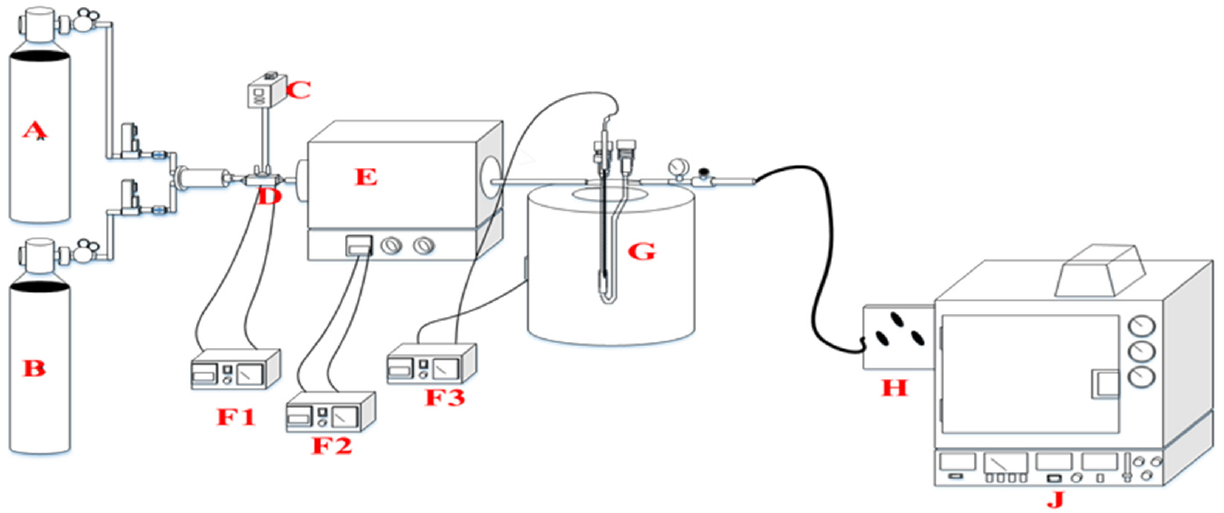
Figure 10. Schematic flow of the reactor design: A: N 2 , B: H 2 , C: pump, D: evaporator, E: evaporator, F1–F3: temperature controller, G: fixed-bed reactor in the furnace, H: gas sample, J: gas chromatog- raphy.